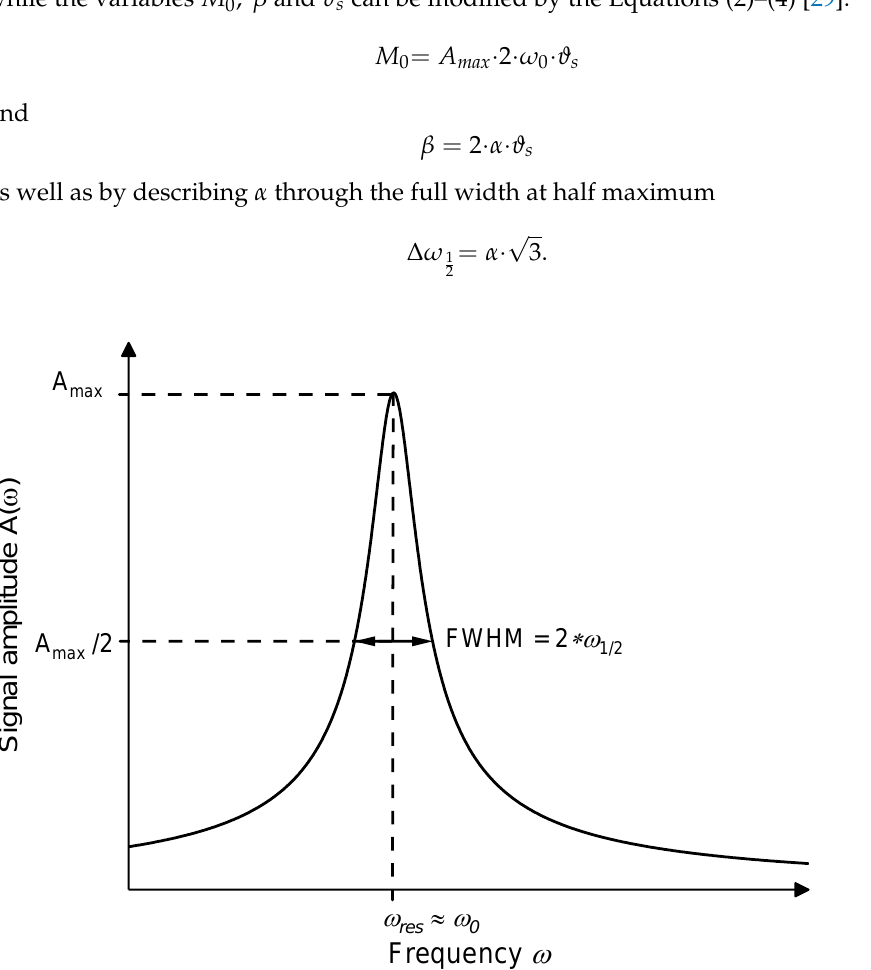
Figure 4. The resonance curve of a forced oscillation with full width at half maximum.